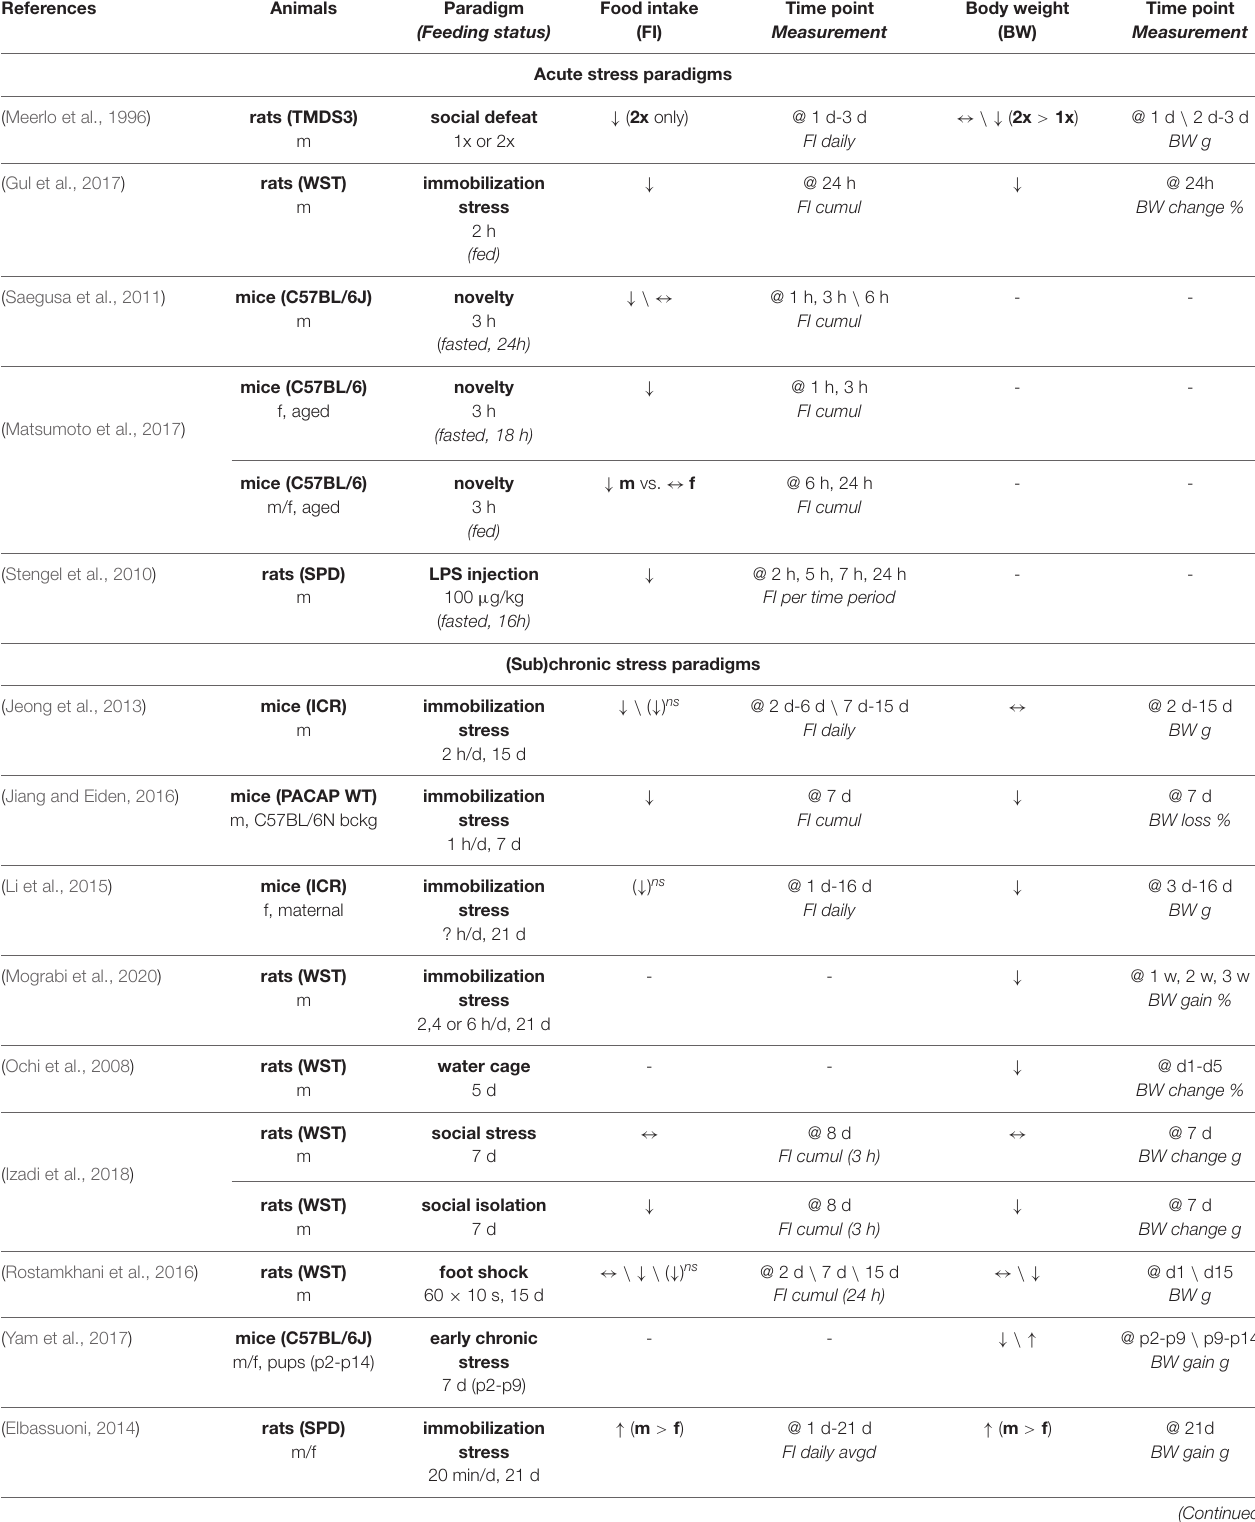
TABLE 2 | Effect of stressors on food intake in